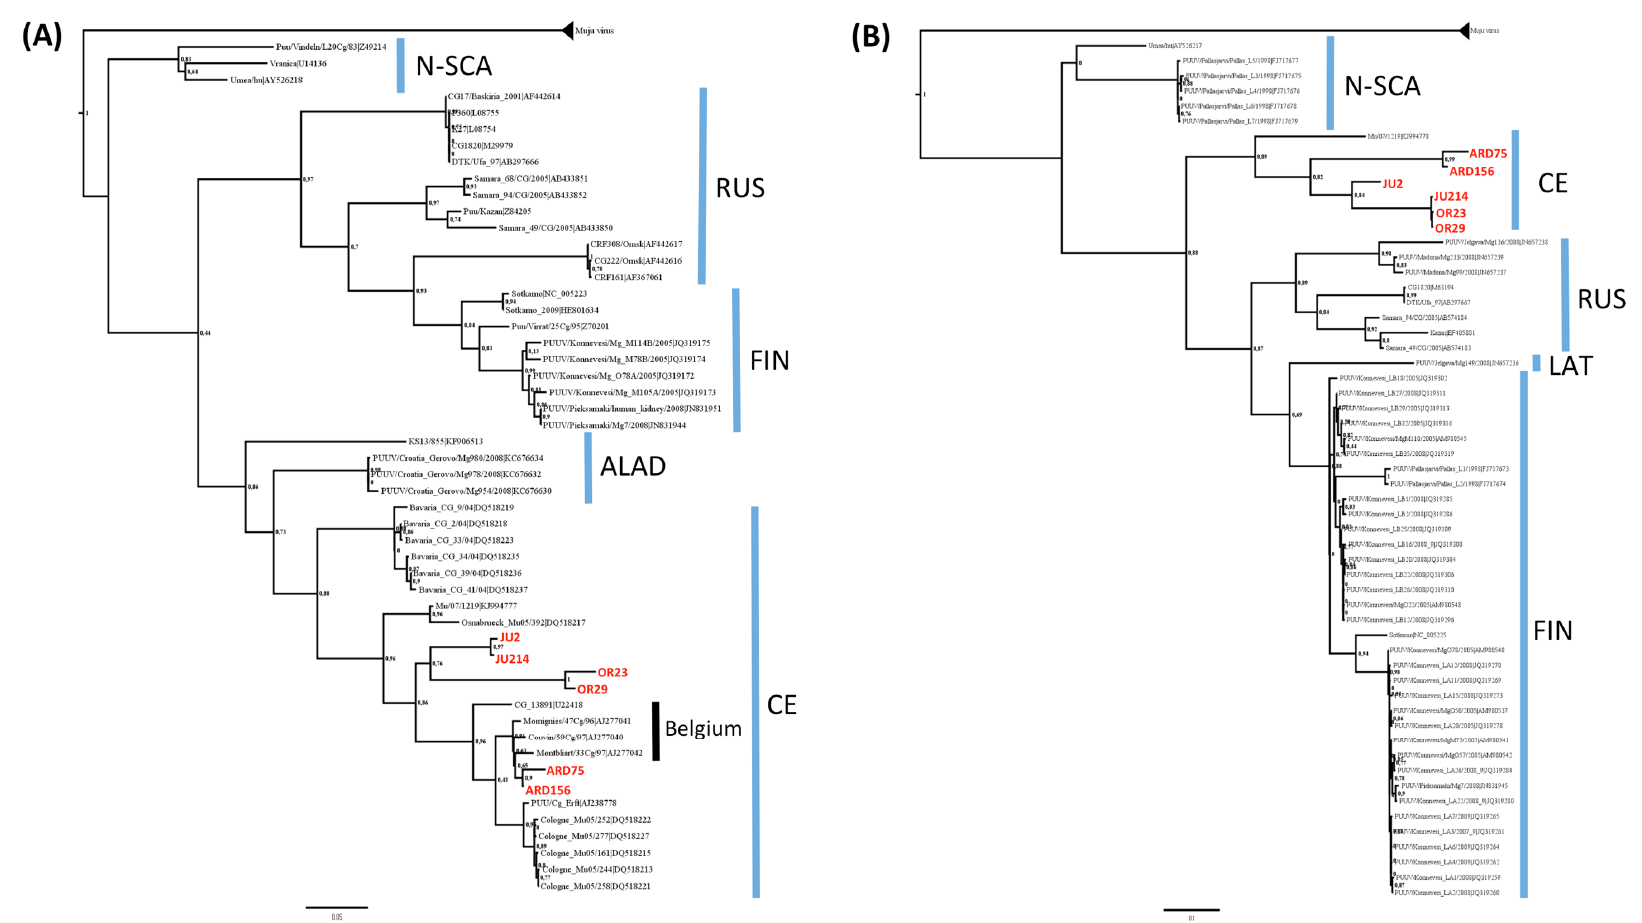
Figure 3. Phylogenetic trees based ( A ) on the partial (2484–3010 nt) M segment sequences and ( B ) on the partial (577–989 nt) L segment sequences of PUUV. Scale bar represent the average number of substitutions per site. French isolates are in red. Blue bars indicate known PUUV lineages.